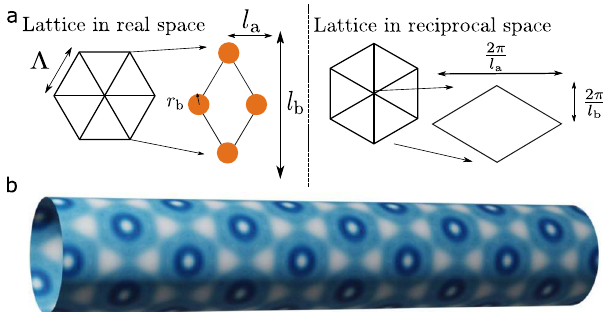
Fig. 4 Parameterisation of the lattice and the numerical density pro fi le.